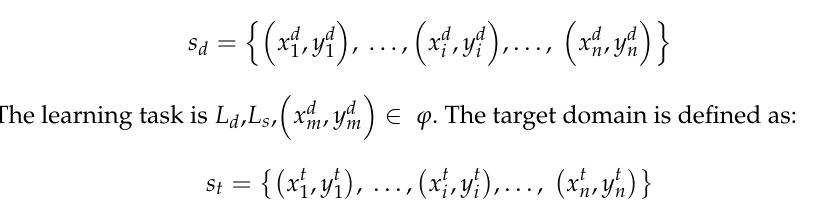
Figure 6. Target model (modified Inception V3) for feature extraction. 3.6. Serial Based Extended Fusion The fusion of features is becoming a popular technique for improved classification results. The main advantage of this step is to improve the image information in terms of features. The improved feature space increases the classification performance. In the proposed work, a Serial based Extended (SbE) approach is implemented. In this ap-